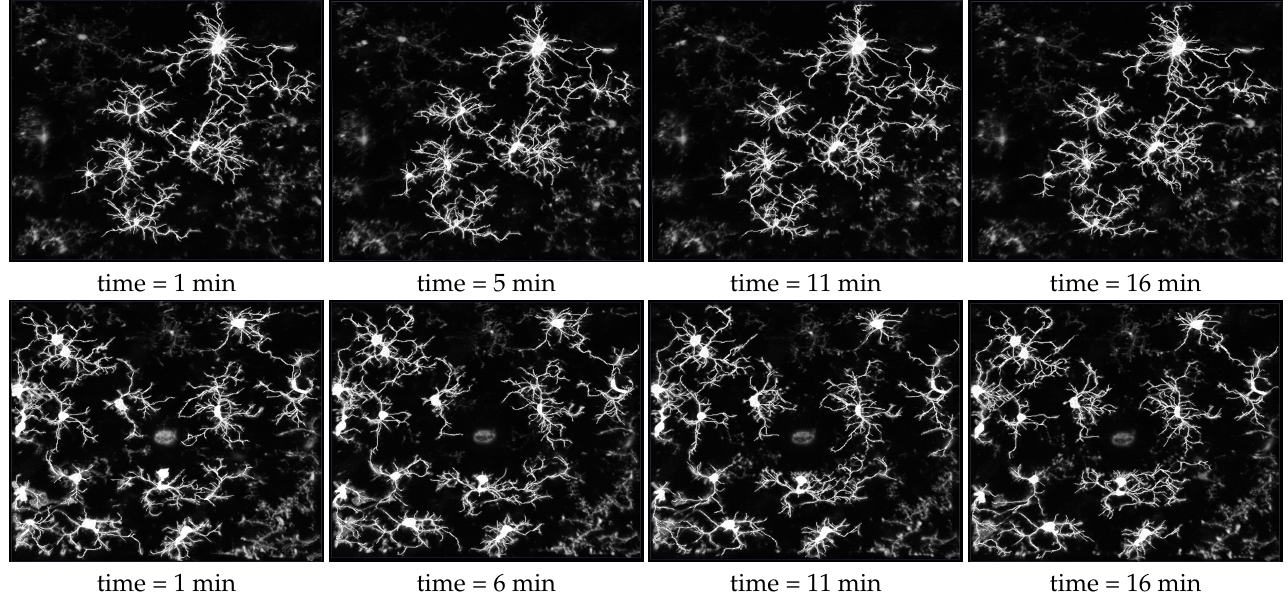
Figure 8. Reconstruction results of 3D microglia images over time. The video of the reconstruction results for the top and bottom rows could be found in Supplementary Information materials SI2 and SI4, respectively.